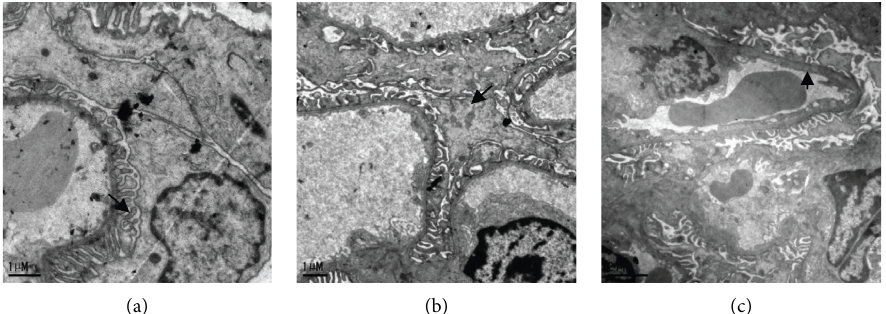
Figure 1: Normal control group. (a) Basement membrane is even and clear, podocyte in order and without fusion or decreasing. (b) Junction of three vascular cavities, podocyte without fusion or decreasing. (c) No basement membrane thickening.